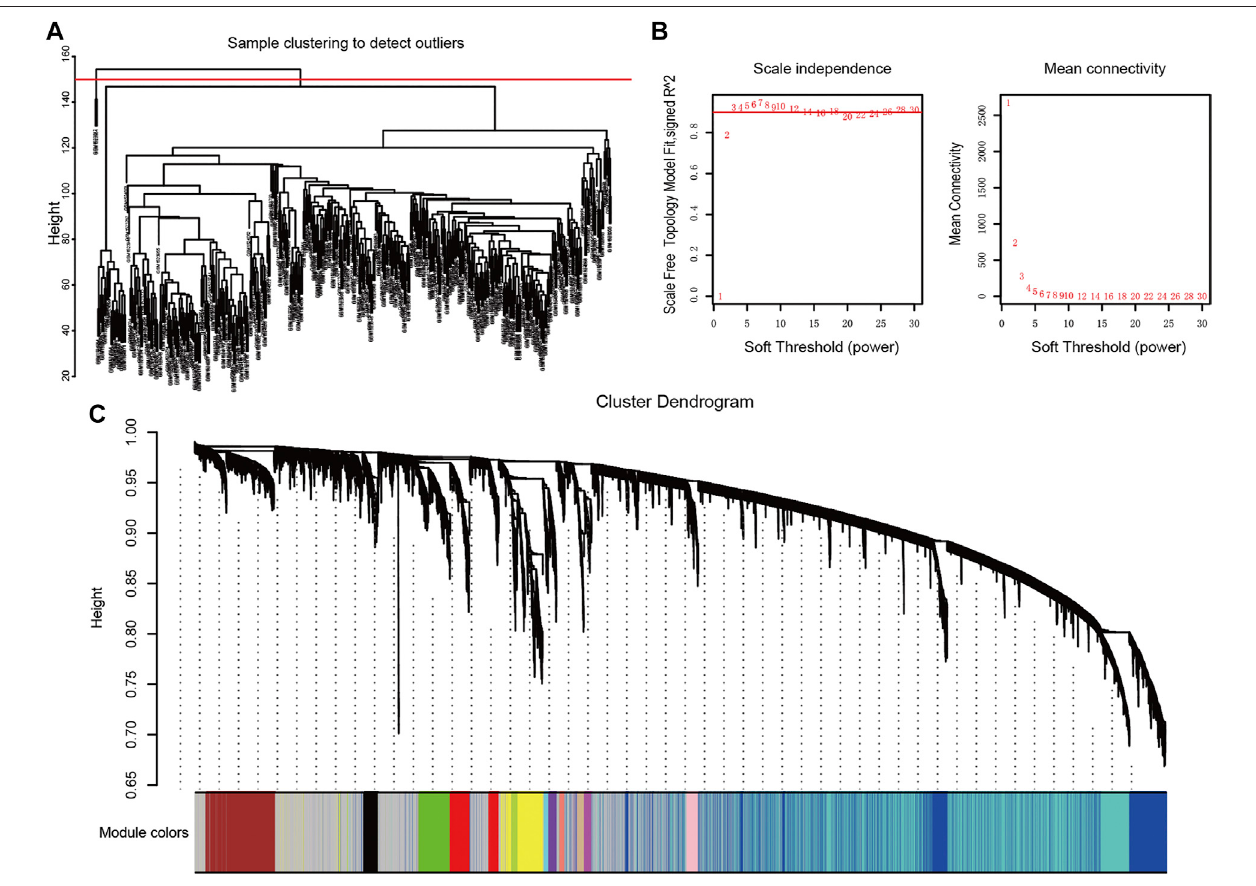
FIGURE 2 | Construction of weighted gene co-expression network (A) Cluster dendrogram displays the relationship between samples (B) The scale-free fi t index for soft-thresholding powers. Left: the relationship between the soft-threshold and scale-free R2. Right: the relationship between the soft-threshold and mean connectivity. Different modules are labeled in different colors (C) Dendrogram of all genes clustered in GSE66229.